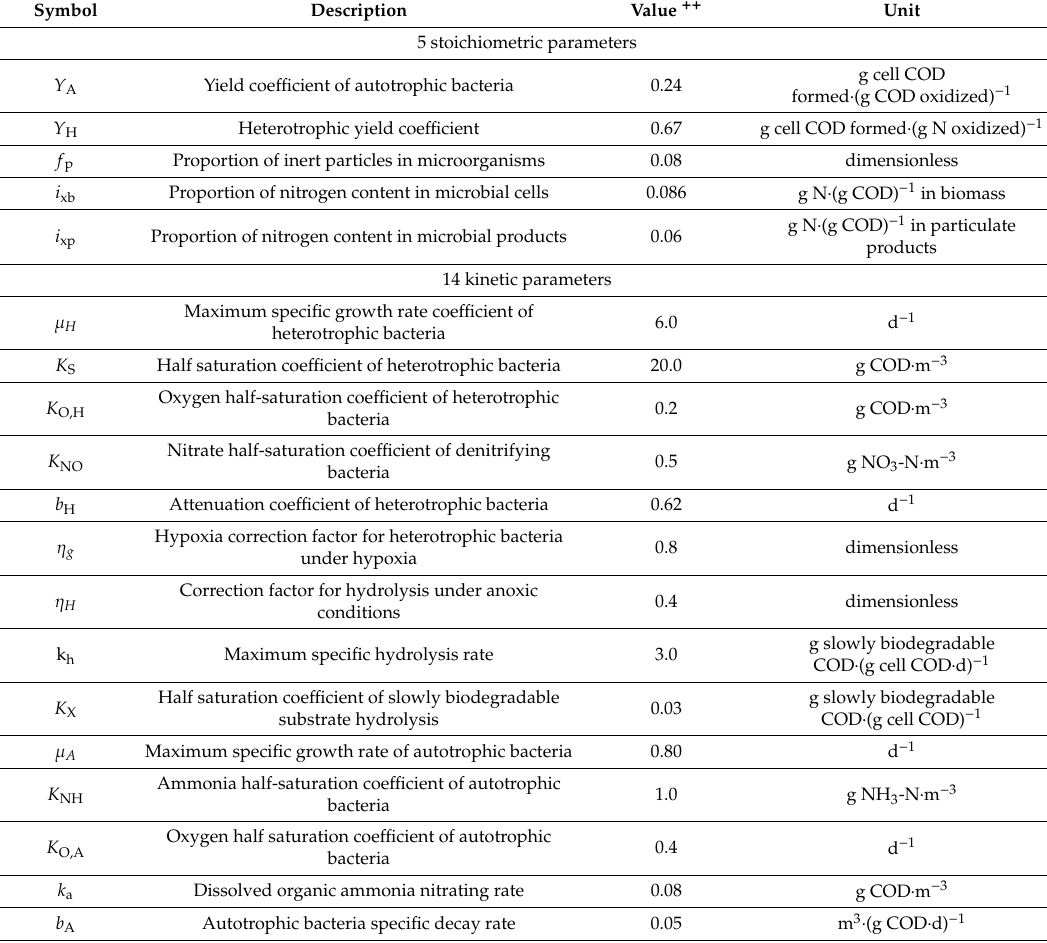
Table 1. Nineteen parameters of ASM1.